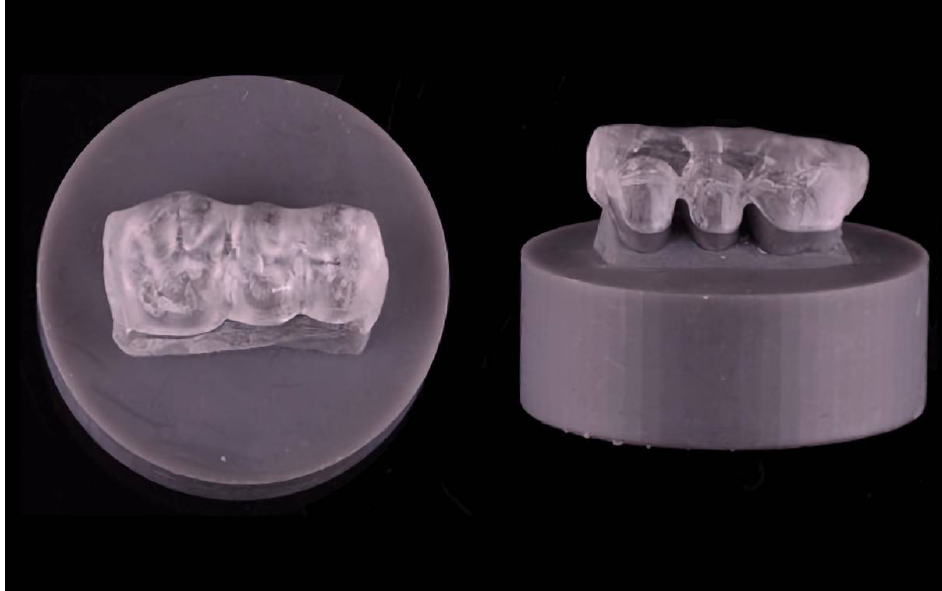
Figure 4. Exemplary fixed partial Michigan splint on the test specimen holder.